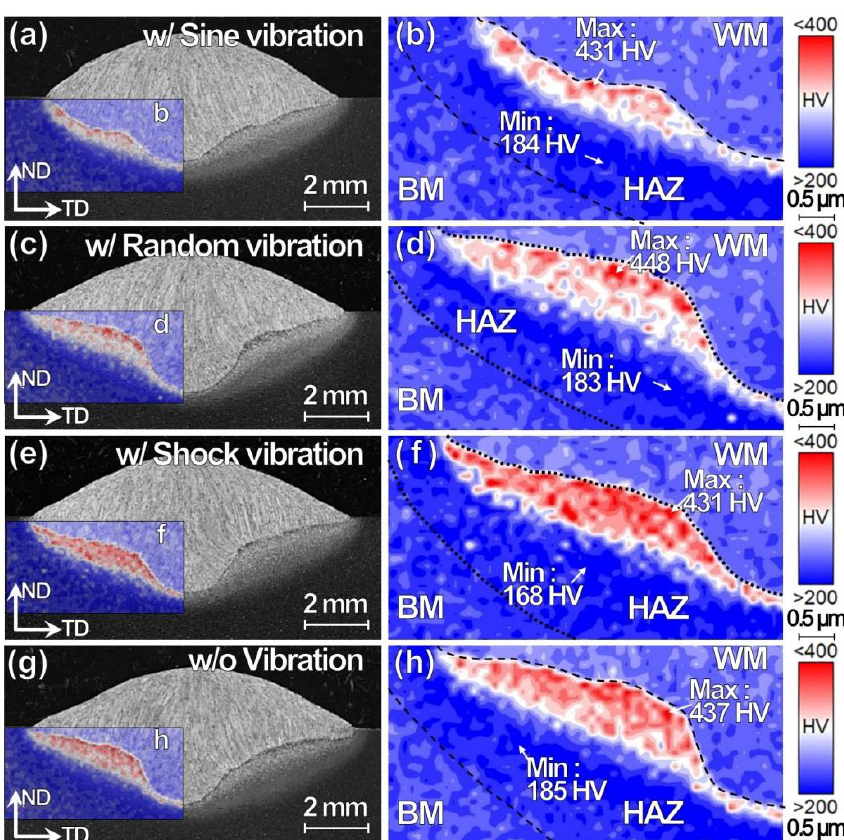
Figure 11. Cross-sectional ( a ), ( c ), ( e ), ( g ) OM images and ( b ), ( d ), ( f ), (h) hardness mappings for TP-GMAW specimens at 1.2 m/min w/ three-mode vibrations including ( a ), ( b ) sine, ( c ), ( d ) random, and ( e ), ( f ) shock modes (F = 250 Hz, G = 1.2 m/s 2 and T = 30 s) and ( g ), ( h ) w/o vibration, for comparison.